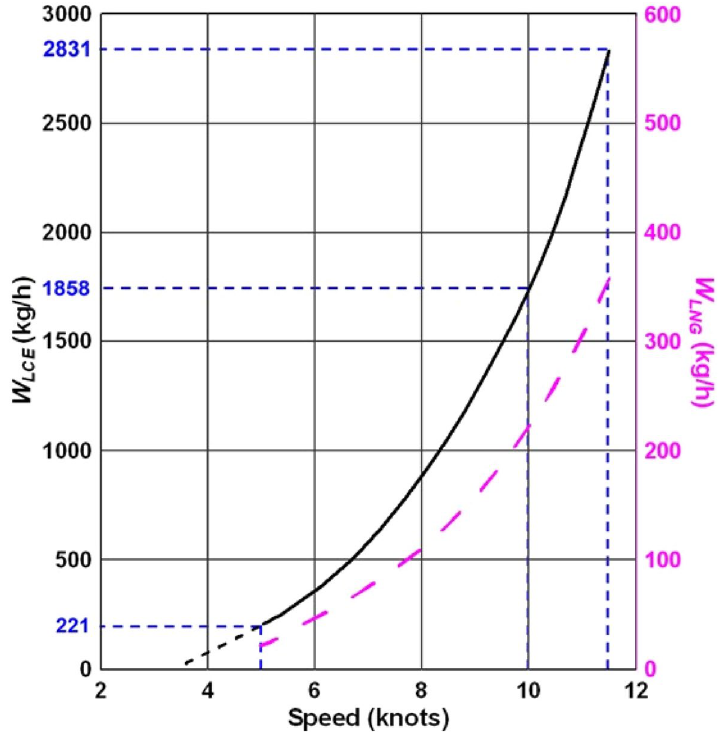
Figure 3. Ship speed dependent maximum MD freezing capacity (solid black curve) and LNG fuel consumption capacity (dotted magenta curve). The horizontal and vertical dotted lines indicate the two distinct points (i.e., low speed and high speed).